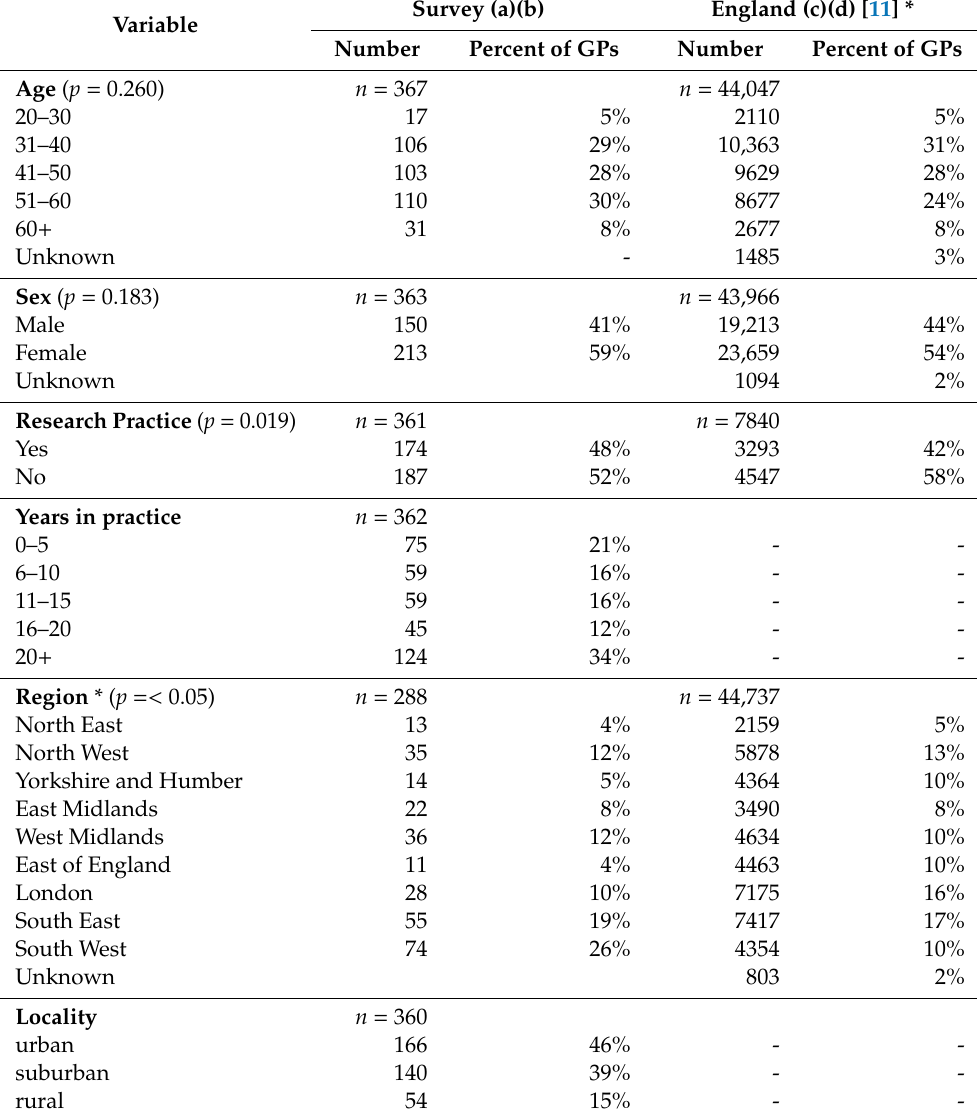
Table 1. Respondent reported age, sex and number of years in practice compared to national data, where available. Statistical comparisons made using the Chi-square test (significant at the 5%